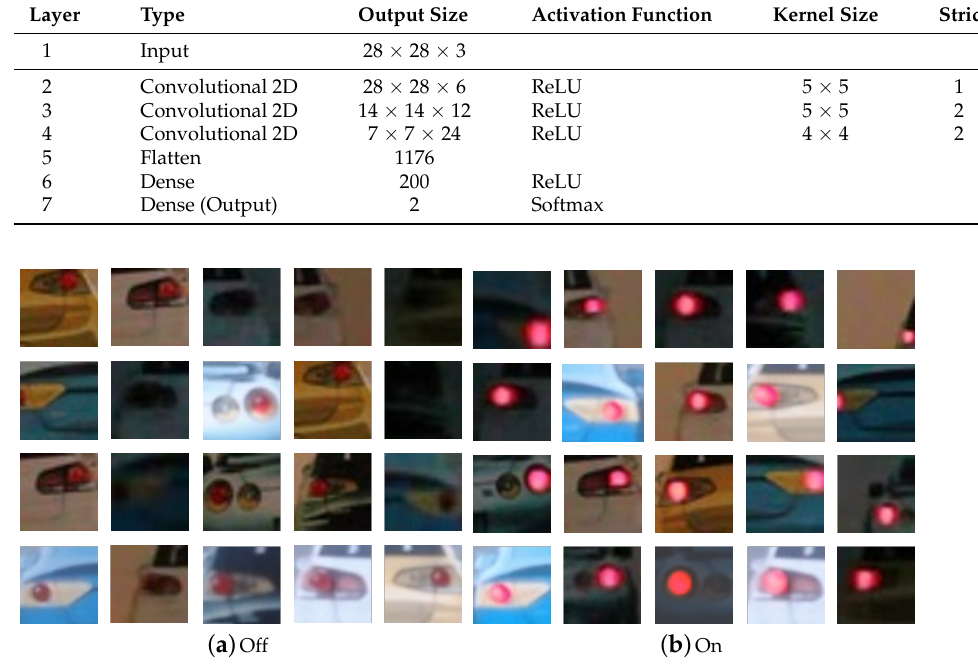
Figure 12. Excerpt of images used as training